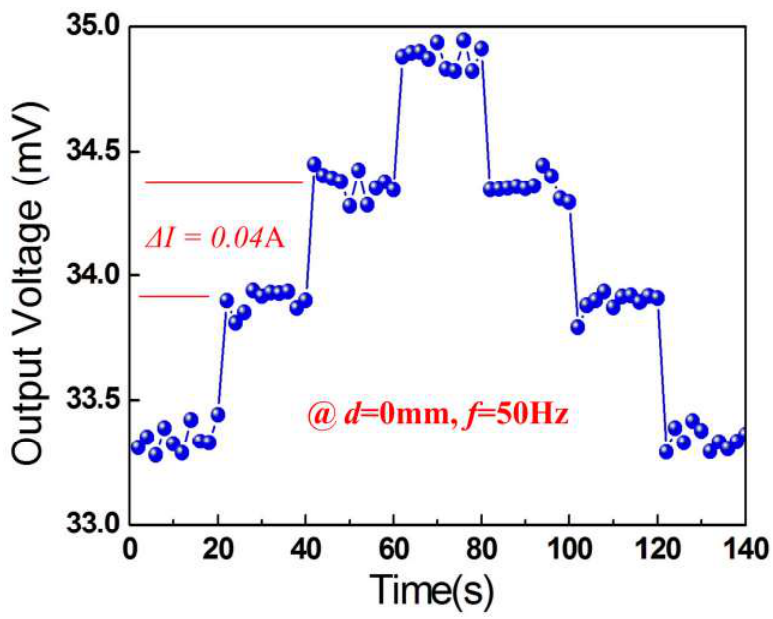
Figure 6. Resolution of the device to the power-frequency current step of 0.04 A at d = 0 mm.